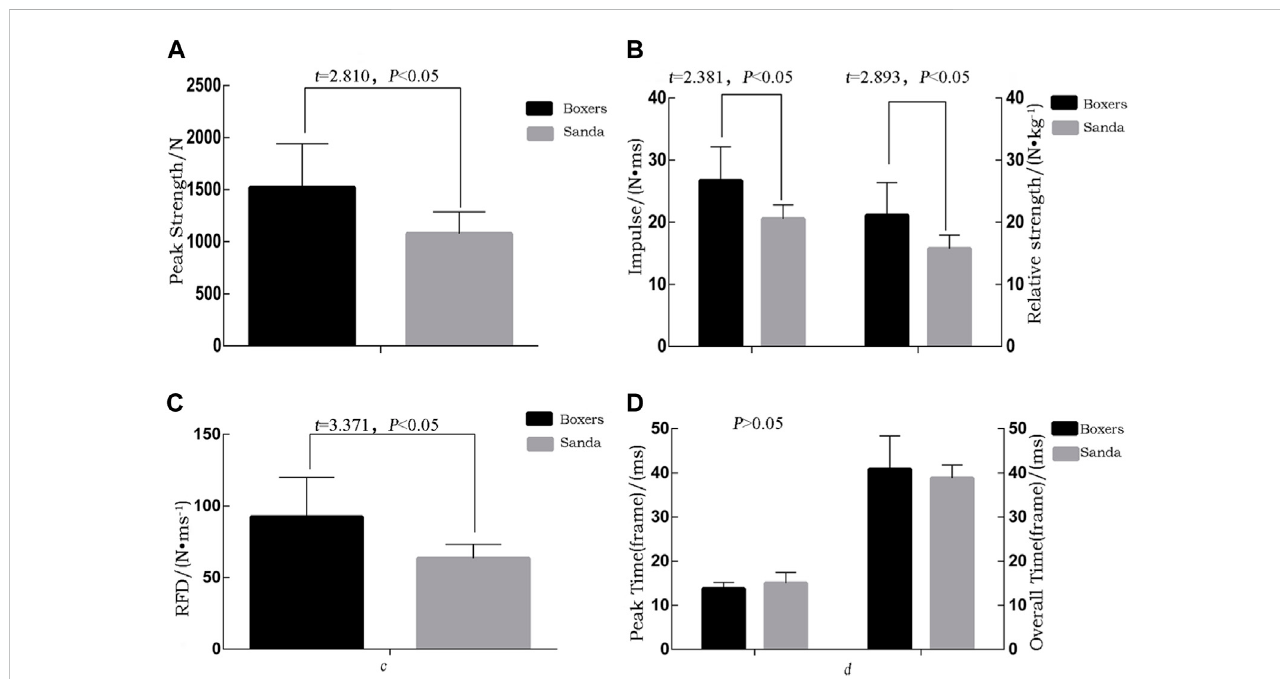
FIGURE 3 (A) peakstrengthofstraightpunchesforboxingandSanda; (B) relativestrengthoftheimpulse; (C) peakforce/time; (D) forceandtimecurveofthetarget.